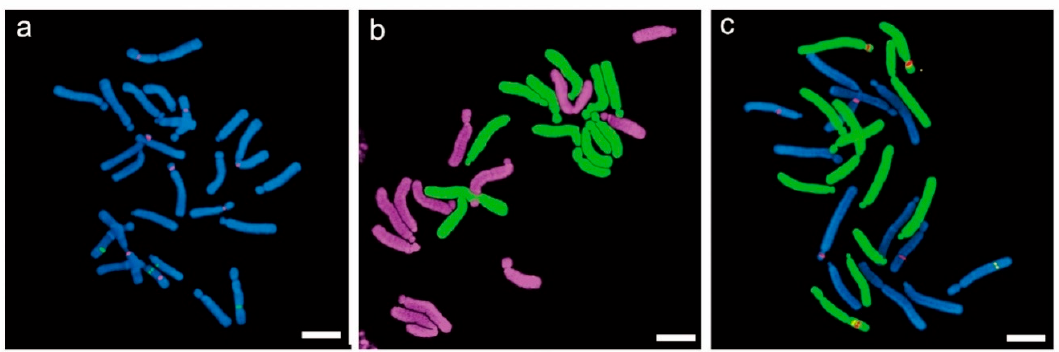
Figure 4. In situ hybridization of diploid (2 n = 2 x = 24) Lilium. ( a ). FISH analysis of intraspecific F1 using 5S and 45S ribosomal DNA; ( b ). GISH analysis of interspecific ( L. longiflorum × L. hansonii ) F1 using genomic DNA; and ( c ). FISH and GISH combined analysis of interspecific ( L. longiflorum × L . Oriental hybrid) F 1 using 5S, 45S rDNA, and genomic DNA.